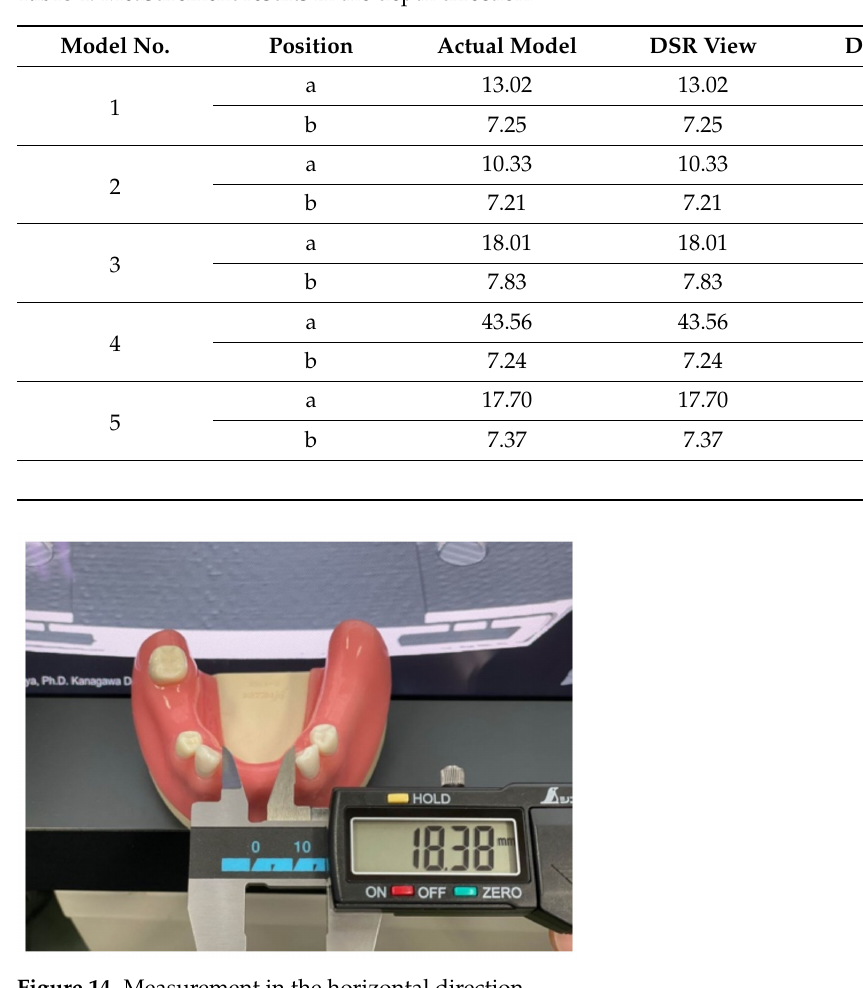
Figure 14. Measurement in the horizontal